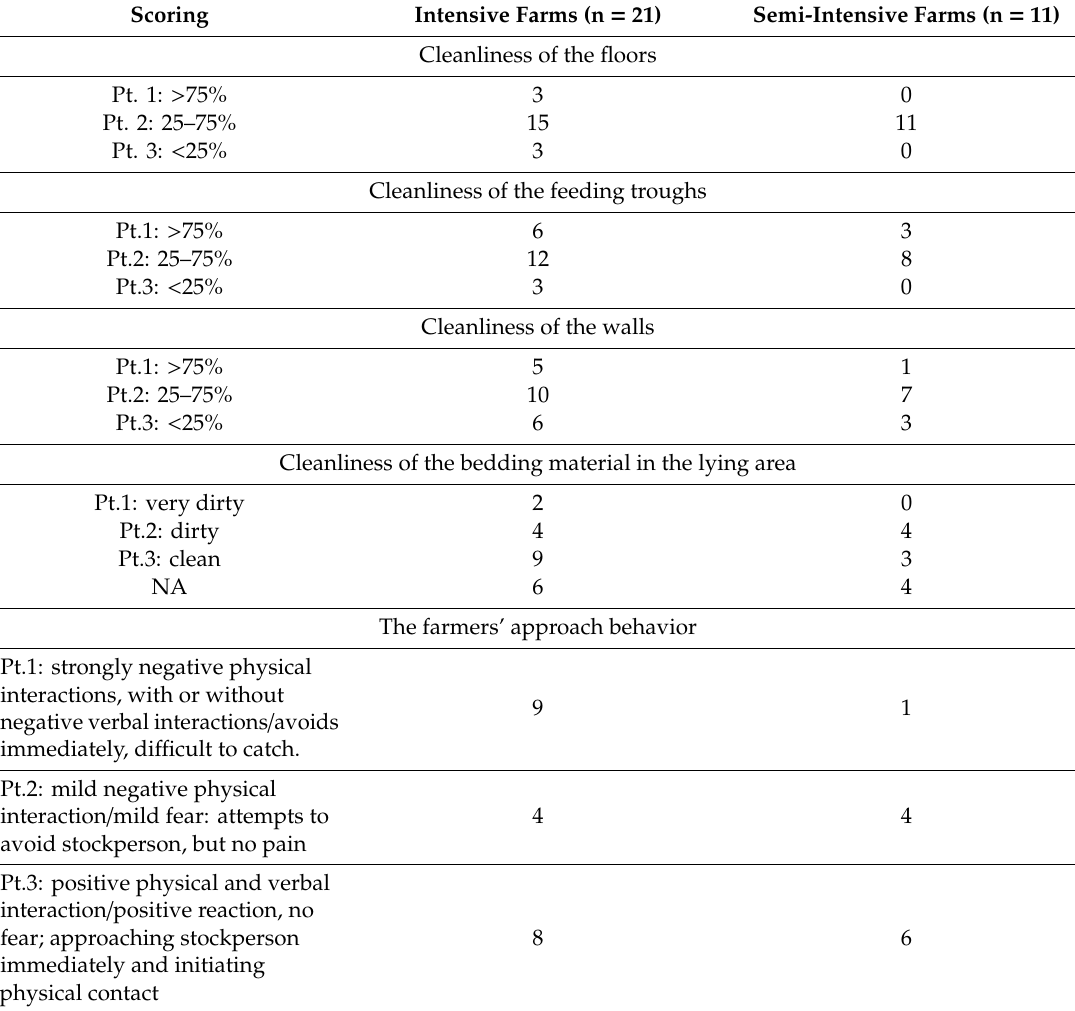
Table 1. Selected resources and management-based measures scored in intensive and semi-intensive goat farms (see Appendix A Tables A1 and A2), Northwestern